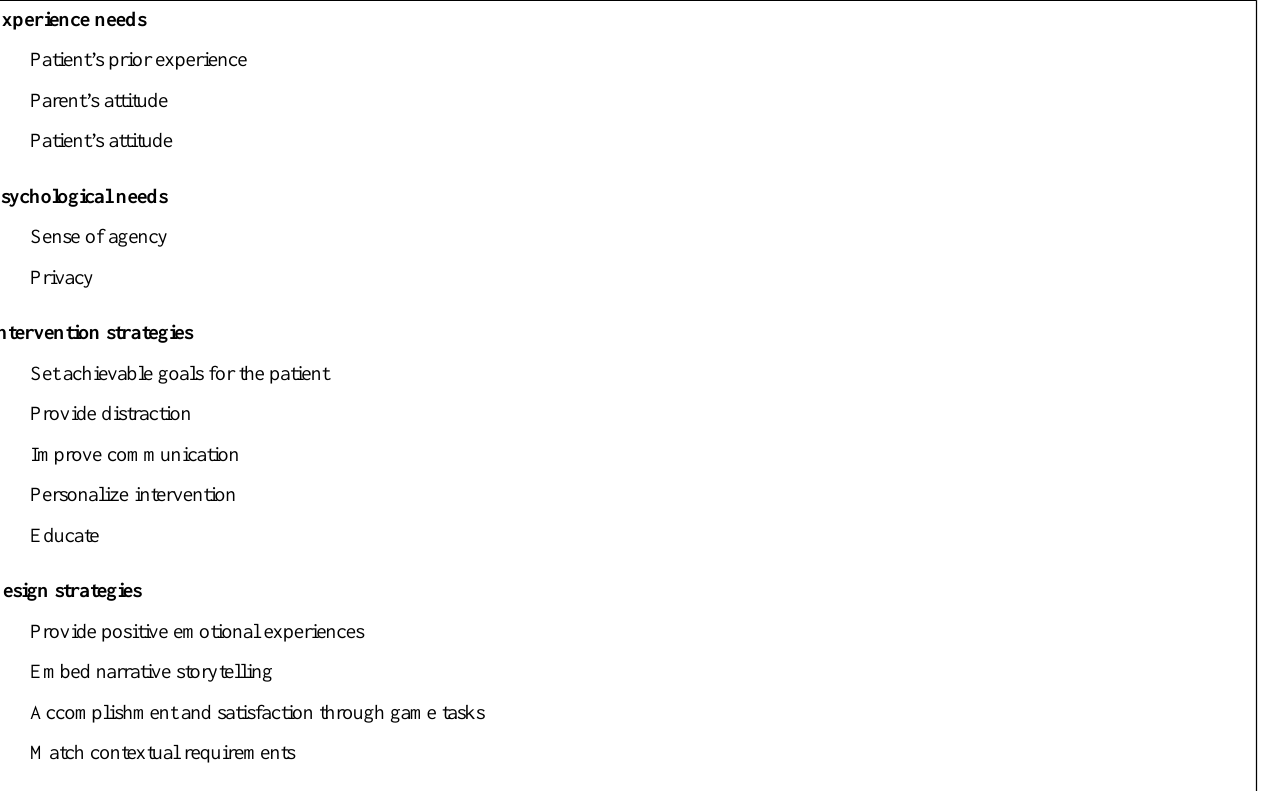
patients to manage their periprocedural